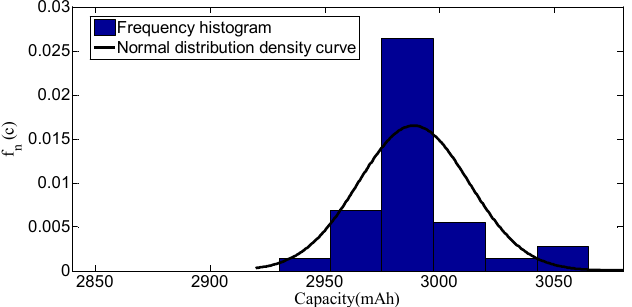
Figure 5. The frequency histogram and theoretical normal distribution density function of the capacity samples before vibration.